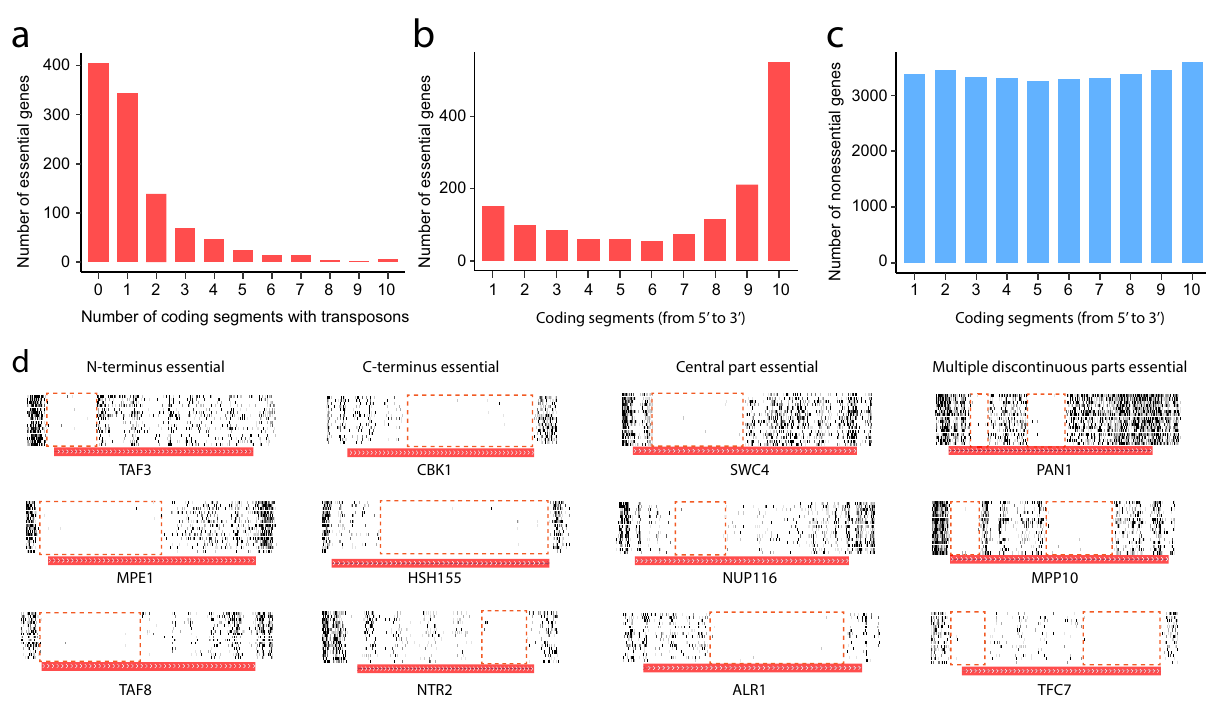
Fig. 6 Most essential genes contain transposon-tolerant coding segments. a Most essential genes tolerate transposon insertions in at least one coding segment. Each segment constitutes one-tenth of the coding region, and a segment is considered tolerant to transposon insertions only when this is true in at least nine strains. b Number of monomorphic essential genes that tolerate transposons in each coding segment. c Number of monomorphic nonessential genes that tolerate transposons in each coding segment. d Examples of genes that are essential only in the N-terminus ( fi rst column), only in the C-terminus (second column), only in the central part (third column), and in multiple discontinuous parts (fourth column). Horizontal bars mark gene locations, with gene names provided below the bars and white arrows indicating transcriptional directions. Source data are provided as a Source Data fi